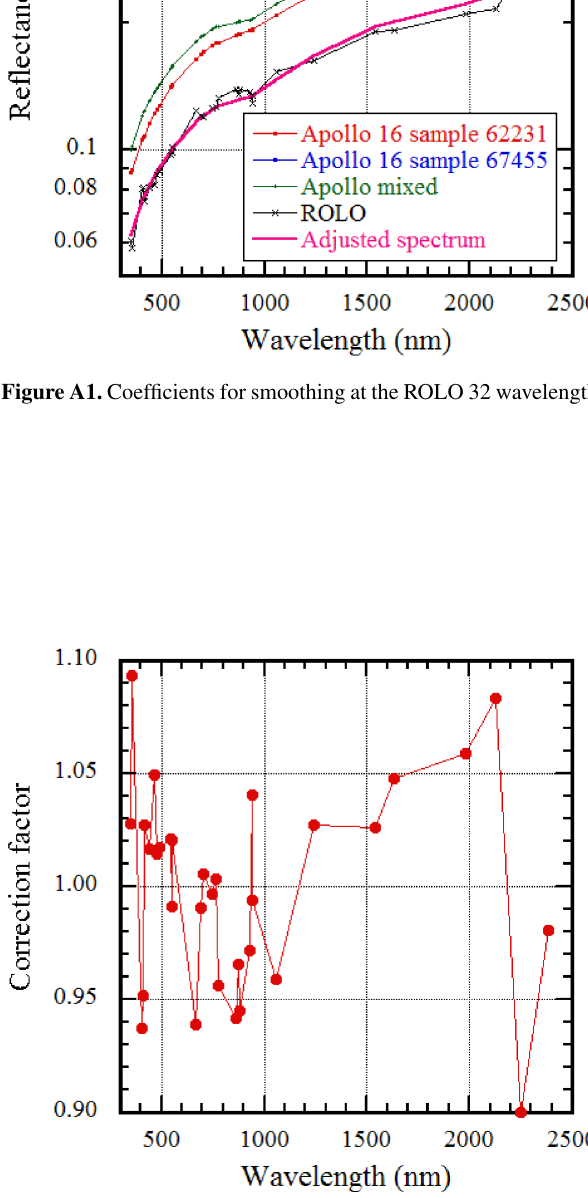
Figure A2. ROLO smoothed and adjusted